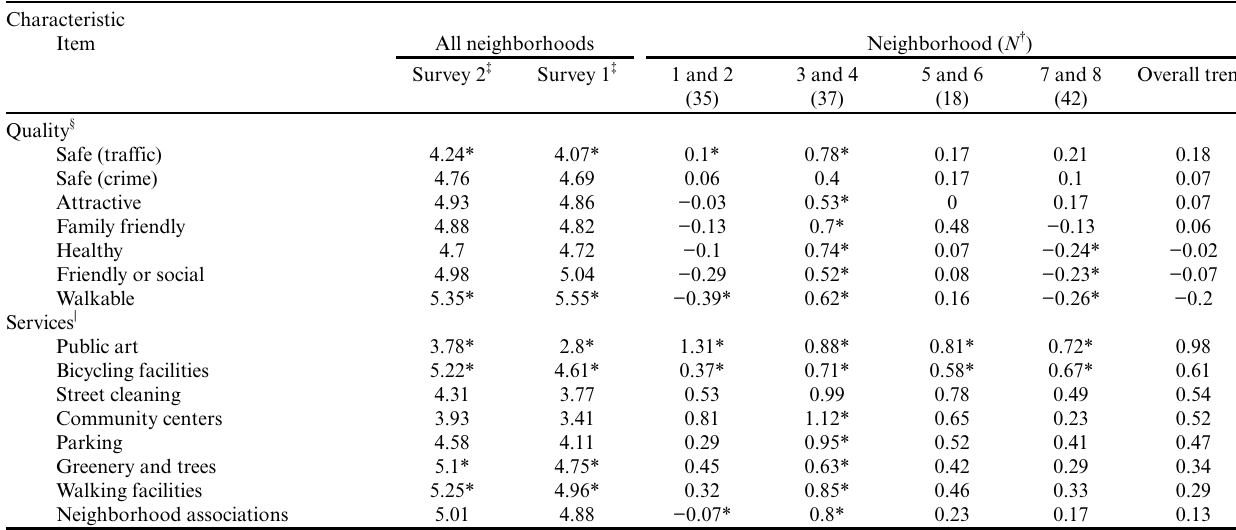
Table 2. Resident’s perceptions of neighborhood quality and